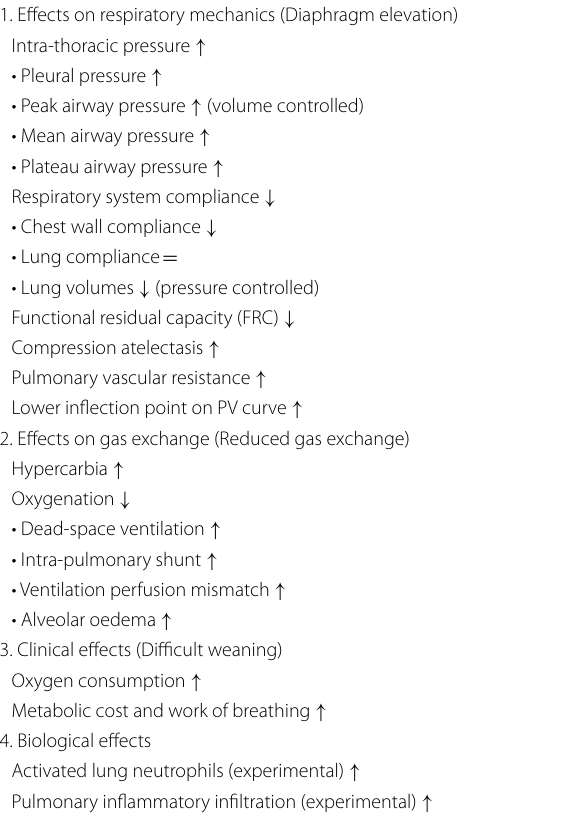
Table 2 Respiratory effects related to increased